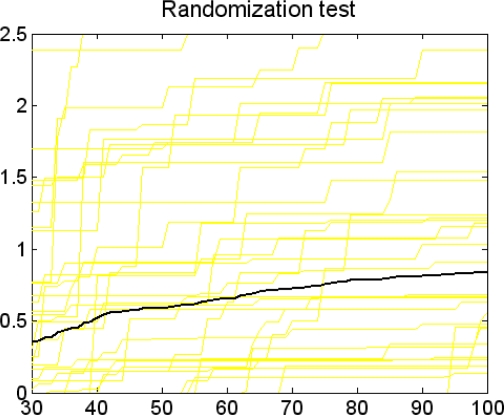
GAPLSOPT(1) test